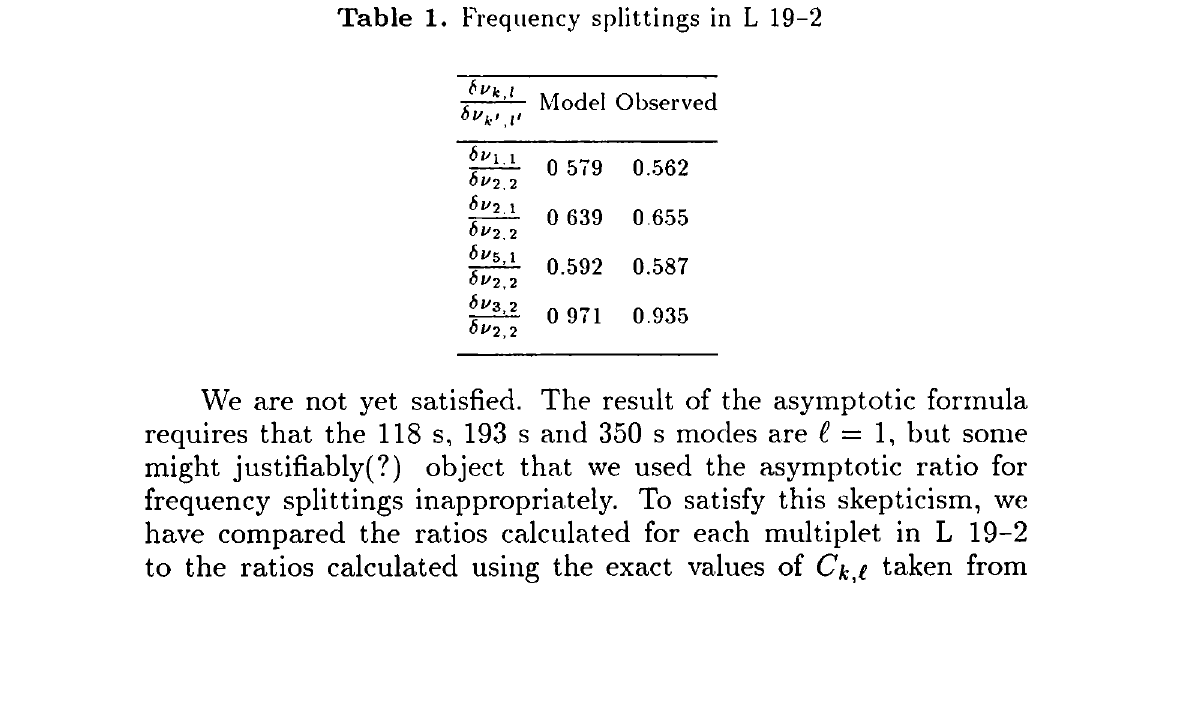
Table 1. Frequency splittings in L